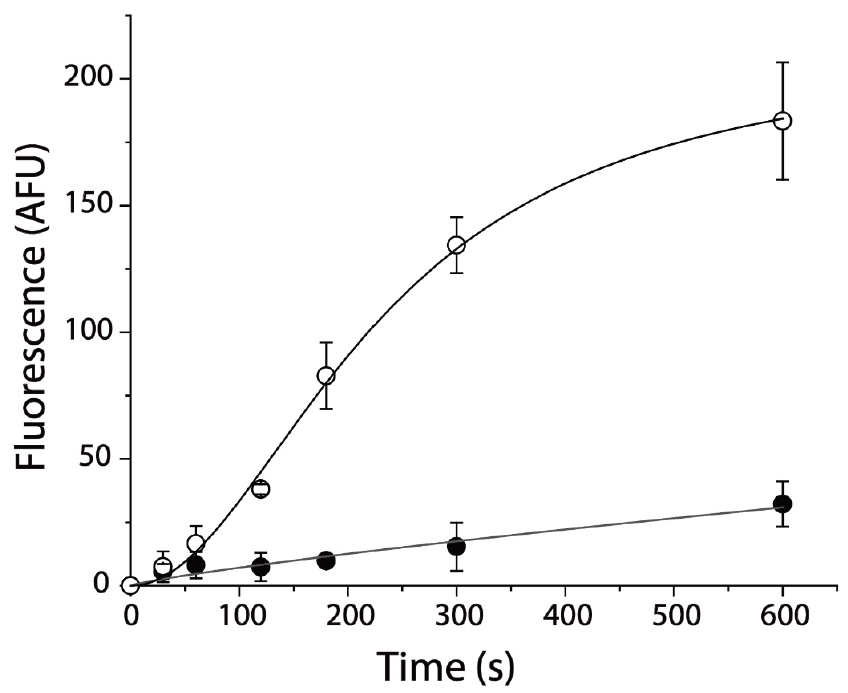
Figure 1. APP + influx inhibited by specific inhibitor of hSERT, fluoxetine. Cells expressing hSERT incubated with APP + in the absence ( ○ ) or presence ( ● ) of 10 μ M fluoxetine at room temperature for the indicated time. After 3 × rapid washing, APP + fluorescence in the cells was measured as described in Section 4. Graph shows representative experiment with APP + influx expressed as fluorescence (AFU). All error bars shown represent SDs from triplicate measurements. Experiment was repeated twice more with similar results.